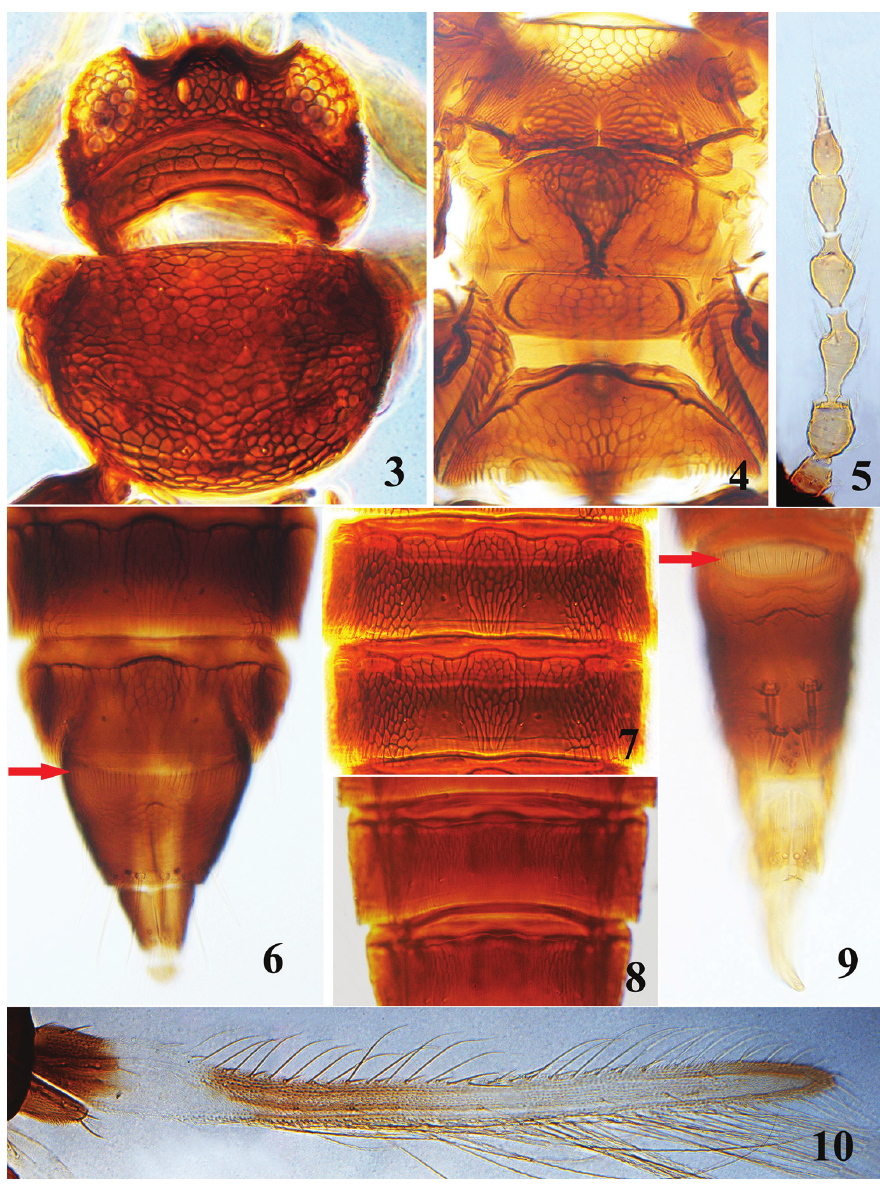
Figures 3–10. Helionothrips lushanensis sp. n. 3 head and pronotum 4 meso- and metanotum and ab- dominal tergite I 5 antenna 6 abdominal tergites VII–X 7 abdominal tergites IV–V 8 abdominal sternites VI–VII 9 abdominal tergites VIII–X of male 10 fore